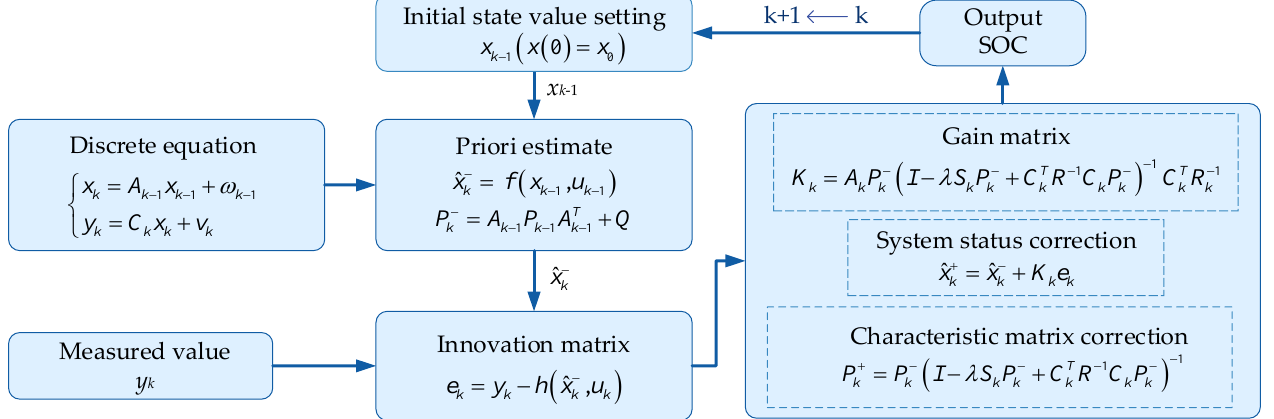
Figure 4. SOC estimation process.